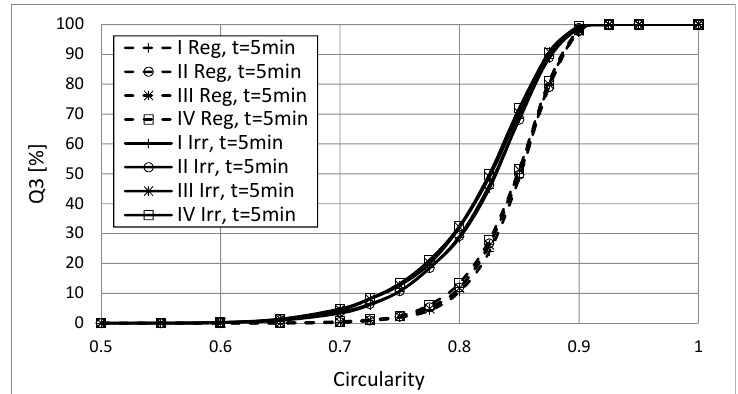
Figure 20. Comparison of particle size distributions of chalcedonite enrichment products for regular and irregular particles.